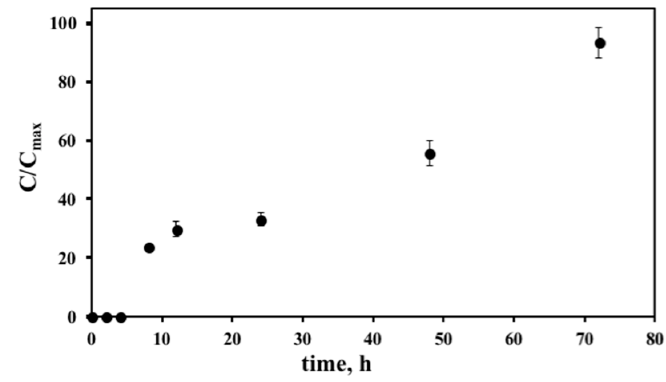
Figure 4. The varlitinib release profile of the PEGAuNPsVarl in PBS at pH 7.4 and 37 °C. C max corresponds to the total amount of the drug added. Results are shown as mean ± SEM of three independent experiments.